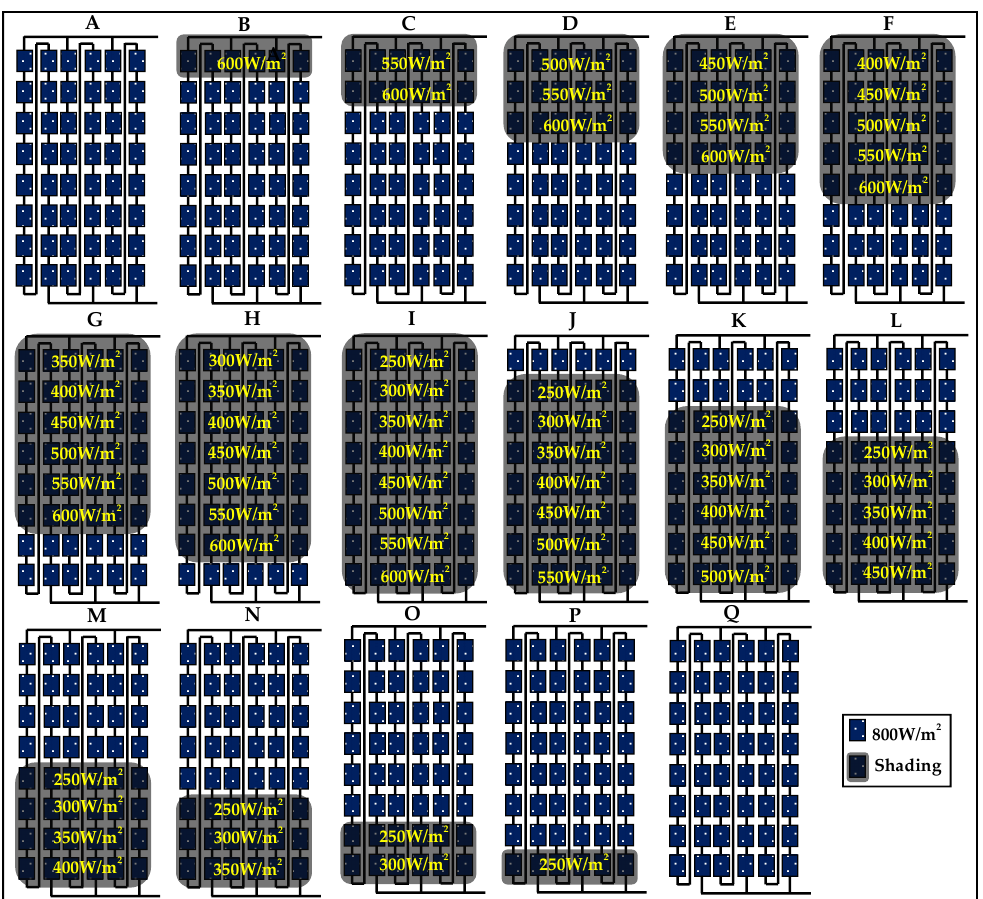
Figure 18. Partial shading cases for 18 × 3 PV arrays with different configurations, static reconfiguration, and the two-step approach.